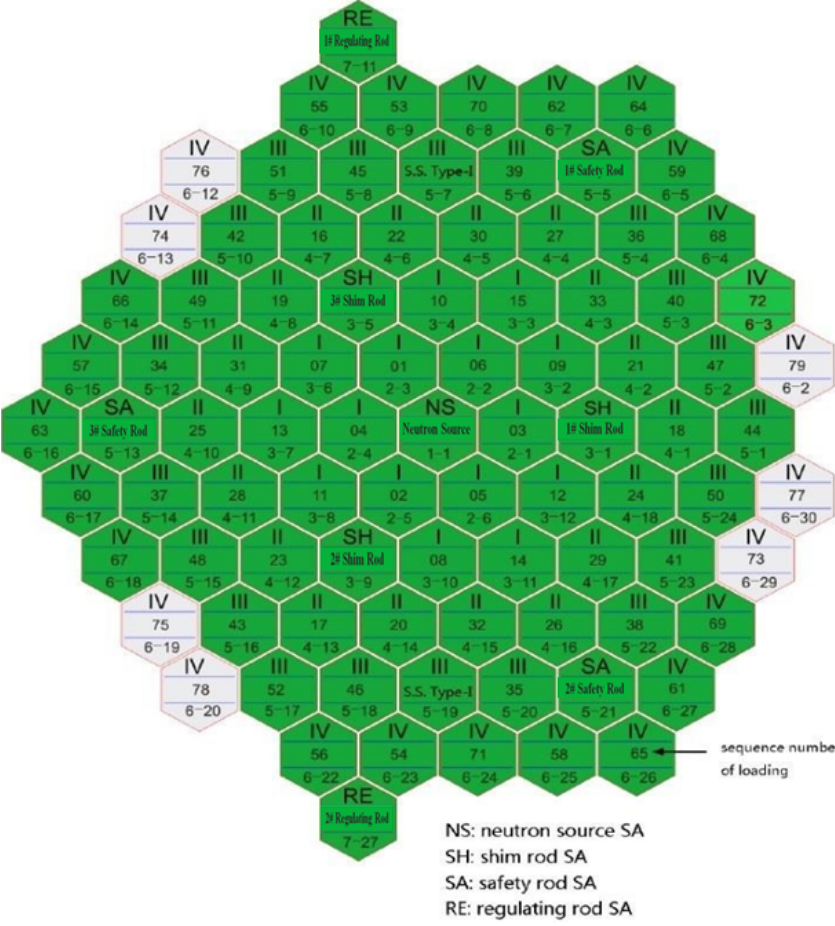
Figure 3. Loading configuration of the clean